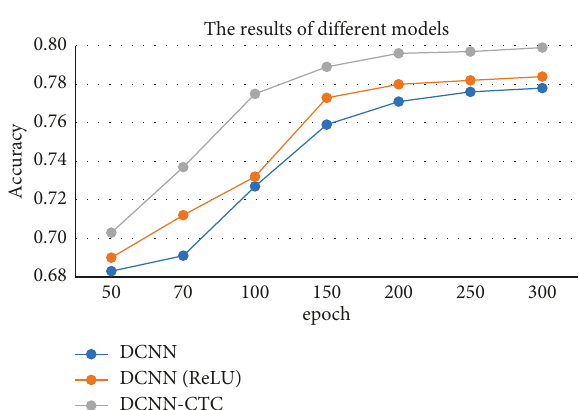
Figure 4: Relationship between the model accuracy and the it- eration